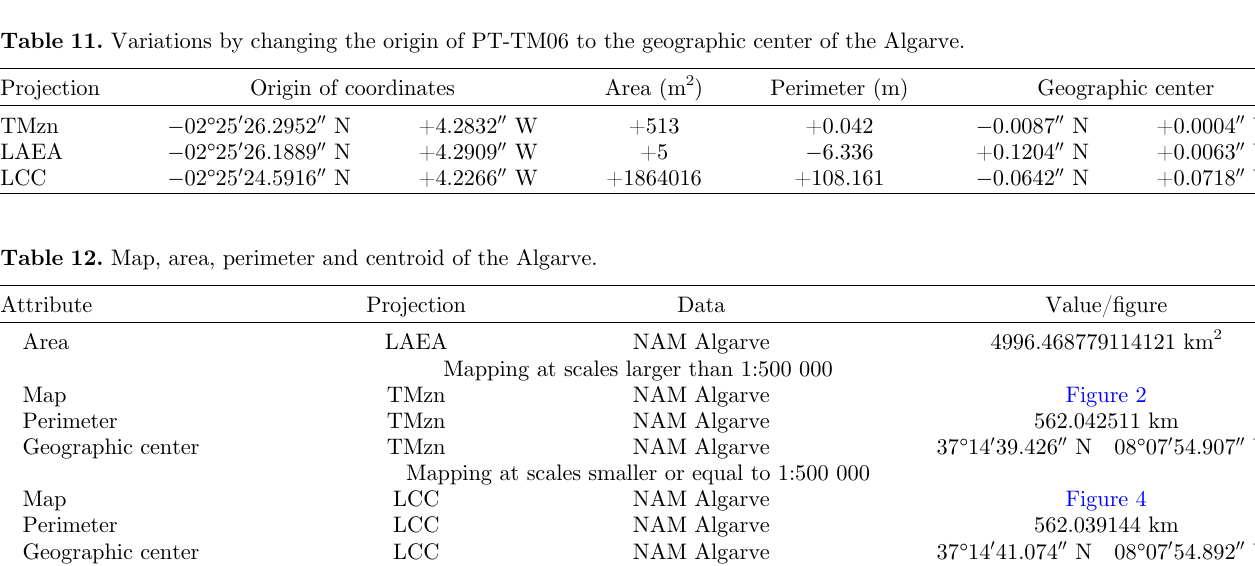
Figure 2 Figure 4